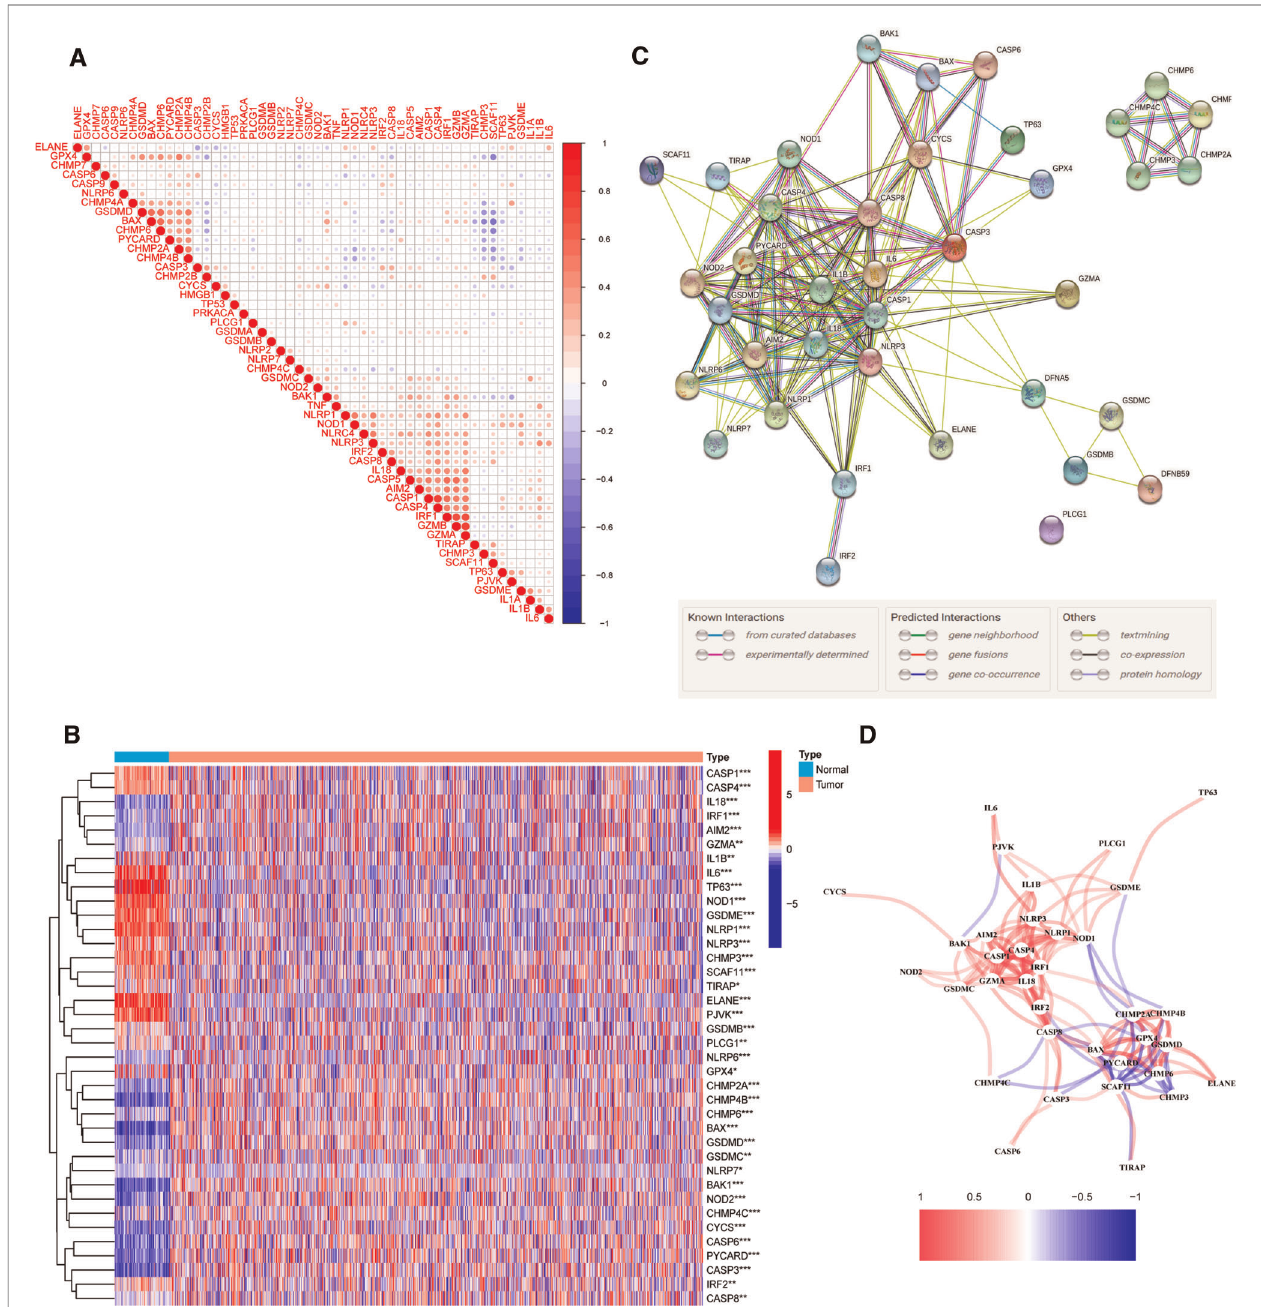
FIGURE 1 | Expression of 38 pyroptosis-related differentially expressed genes PR DEGs in The Cancer Genome Atlas Breast Cancer (TCGA-BRCA) cohort and the interactions among them. ( A ) Correlation analysis among 52 pyroptosis-related (PR) genes. ( B ) Heatmap indicating the expression of 38 PR DEGs between non- cancerous breast tissues and BC. ( C ) Protein – protein interaction network indicating the interactions of 38 PR DEGs. ( D ) Correlation network of 38 PR DEGs. * p <0.05, ** p <0.01, *** p <0.001, ns, not signi fi